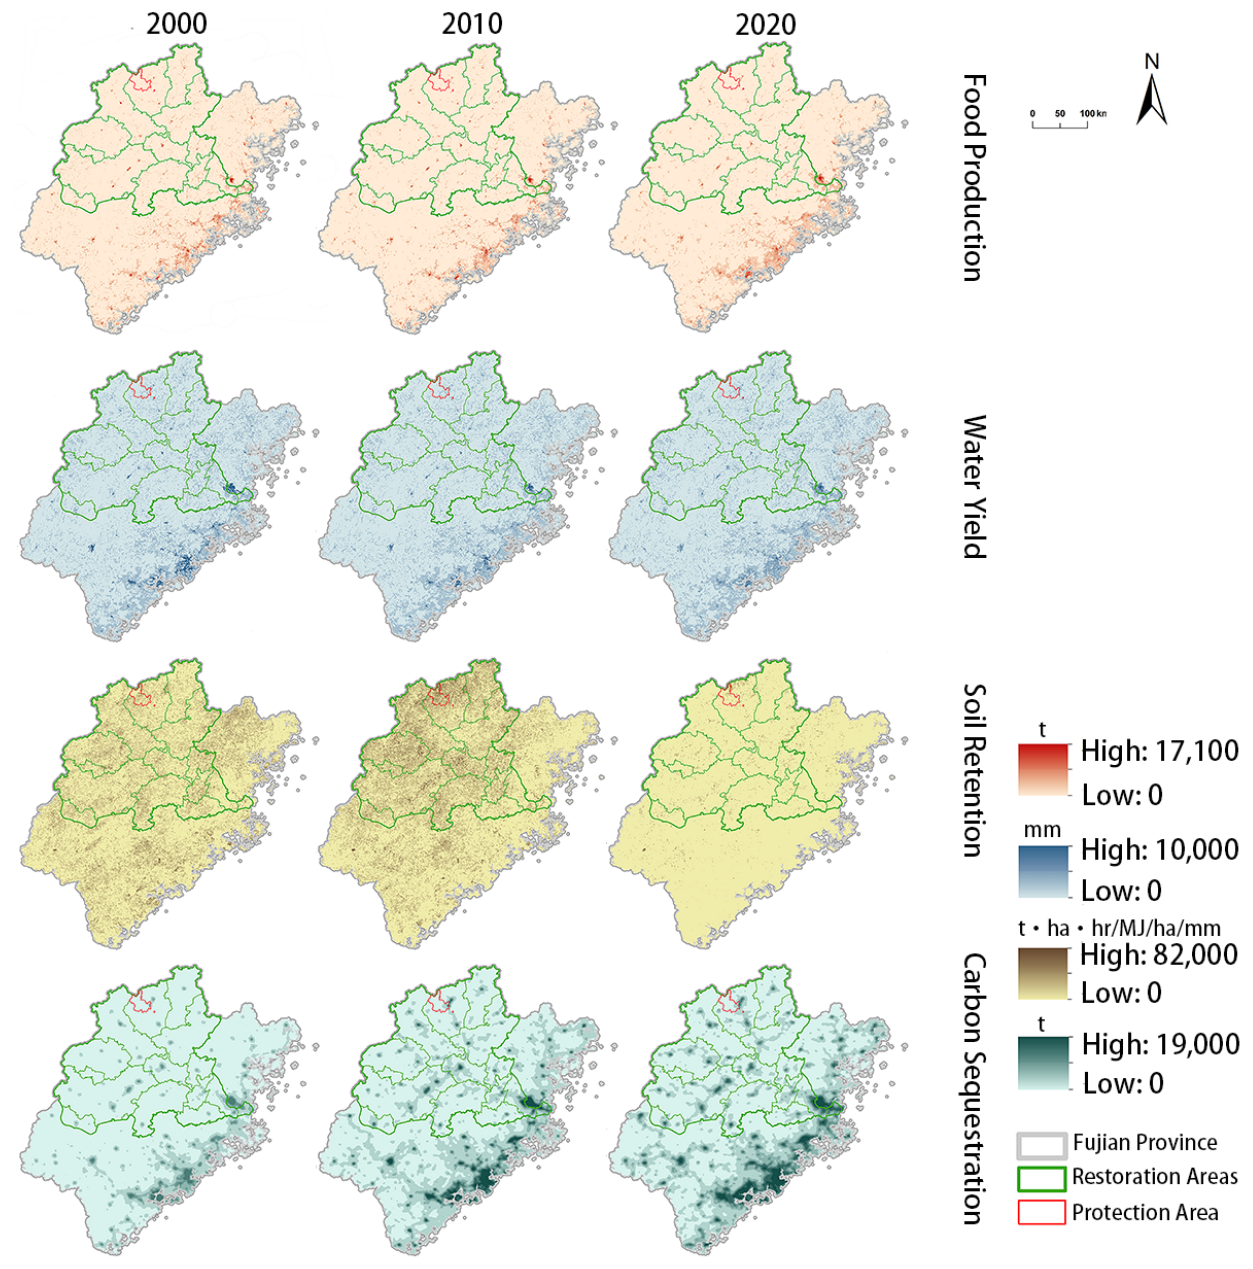
Figure 3. Variation in the ecosystem services demand in the Fujian Province.